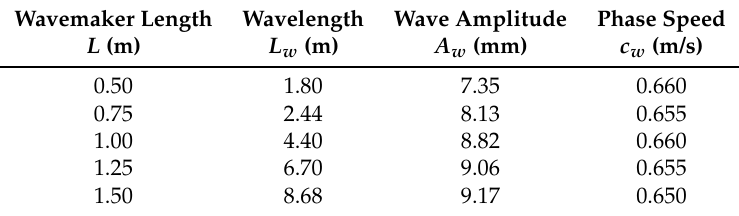
Figure 5. Normalized wave parameters as functions of normalized moving bottom length, L / L 0 . Circle: wavelength, L w / L w ,0 ; square: wave amplitude, A w / A w ,0 ; triangle: phase speed, c w / c w ,0 . Subscript 0 indicates the normalization by the corresponding values at L = 1 m (see Table 1). In all cases, h 0 = 0.03 m, a = 0.02 m, b = 0.5 s, θ = 0, and the upward bottom motion, (1), is imposed. Table 1. Effects of wavemaker length, L : wave parameters of leading elevation waves due to wavemakers of varying lengths. Bottom motion is given in (1) with a = 0.02 m and b = 0.5 s and the constant water depth is h 0 = 0.03 m. The corresponding free-surface records at the hinge are plotted in Figure